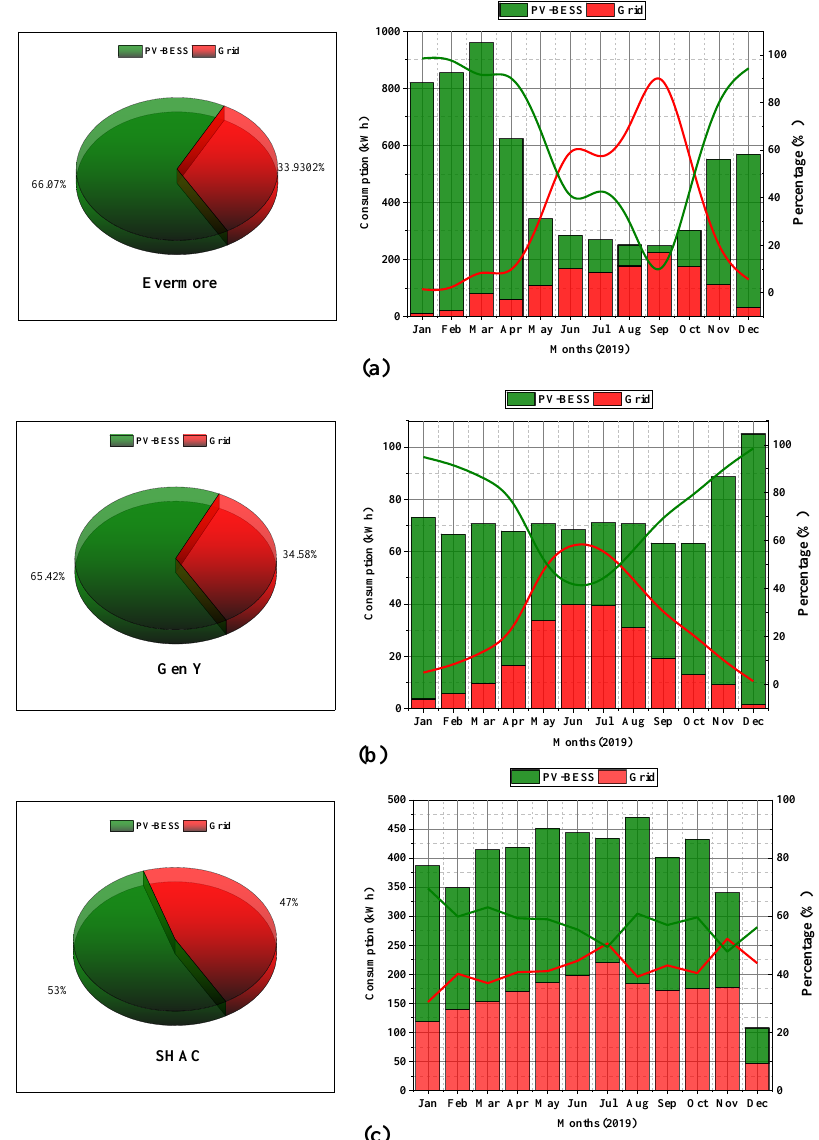
Figure 8. Pie chart of total renewable and grid fraction for CP load at three sites with monthly bar chart of CP instantaneous load distribution according to the Instantaneous consumption (IC) strategy, ( a ) Evermore ( b ) Gen Y ( c ) SHAC.